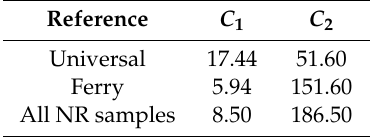
Table 3. The constants C 1 and C 2 for calculating the shift factor [23,24].